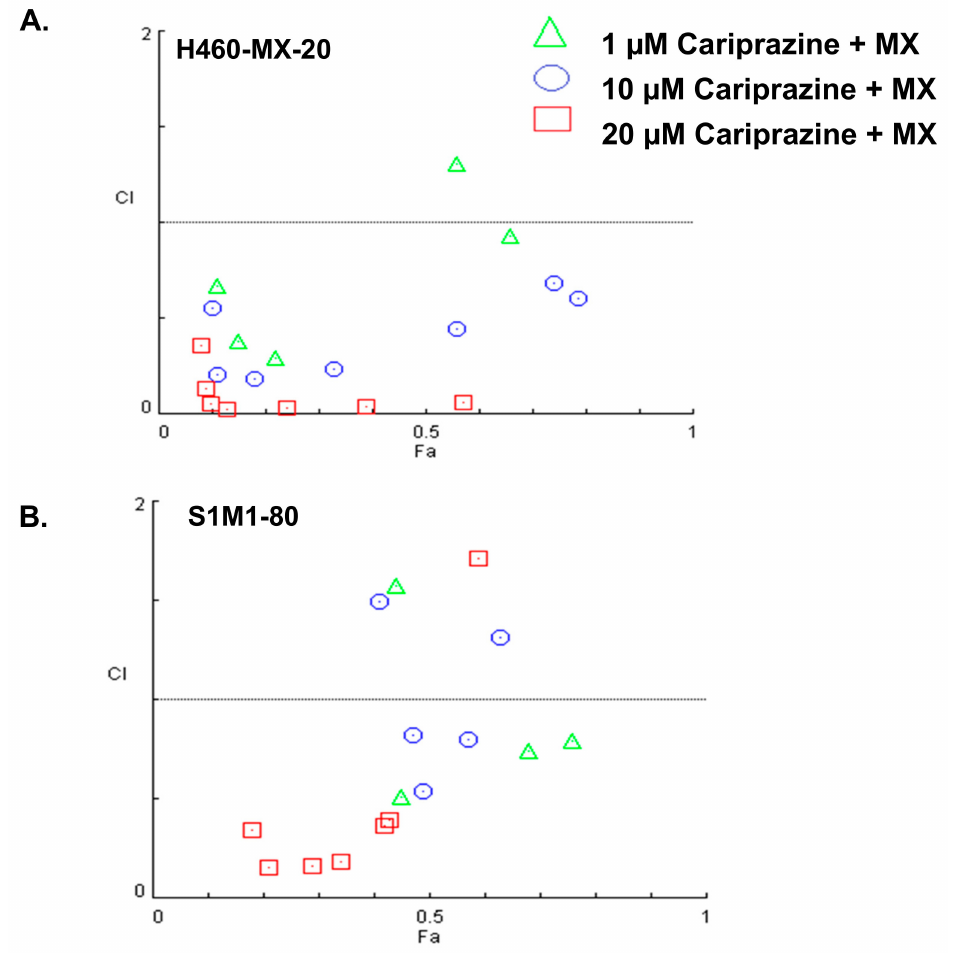
Figure 4. The combination index values for the combination of 1, 10 or 20 µ M of cariprazine, respectively, with 0.1, 0.3, 1, 3, 10, 30, or 100 µ M of MX in ( A ): H460-MX20 cancer cells and ( B ) S1M1-80 cancer cells. The Fa values range from 0 to 1. CI < 1, synergism; CI = 1, additive effect and CI > 1, antagonism. The data represent the mean ± SD of three independent experiments in